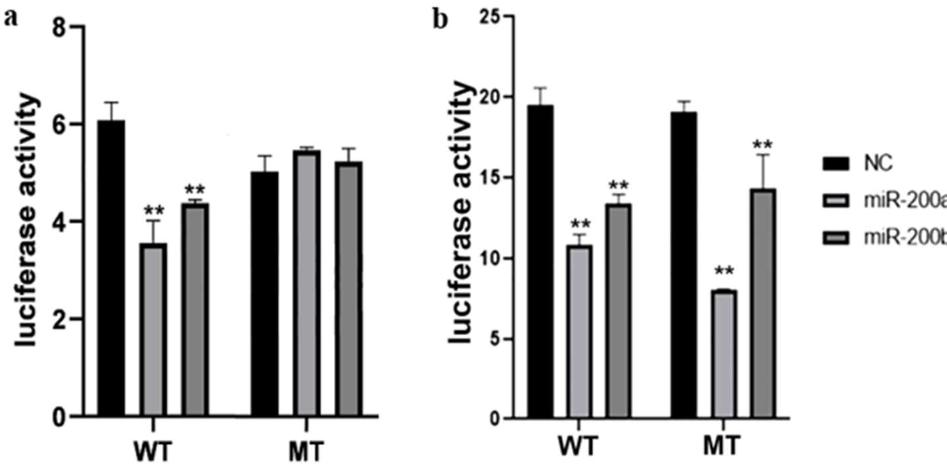
Figure 4. The luciferase activity of the wild and mutant recombinant reporter plasmid ( a ) site 1, ( b ) site 2. ** Indicates a statistically significant difference ( p <